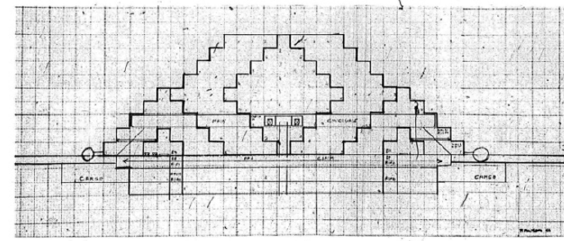
Figure 9. Robert Smithson, Airport Site Map, 1966